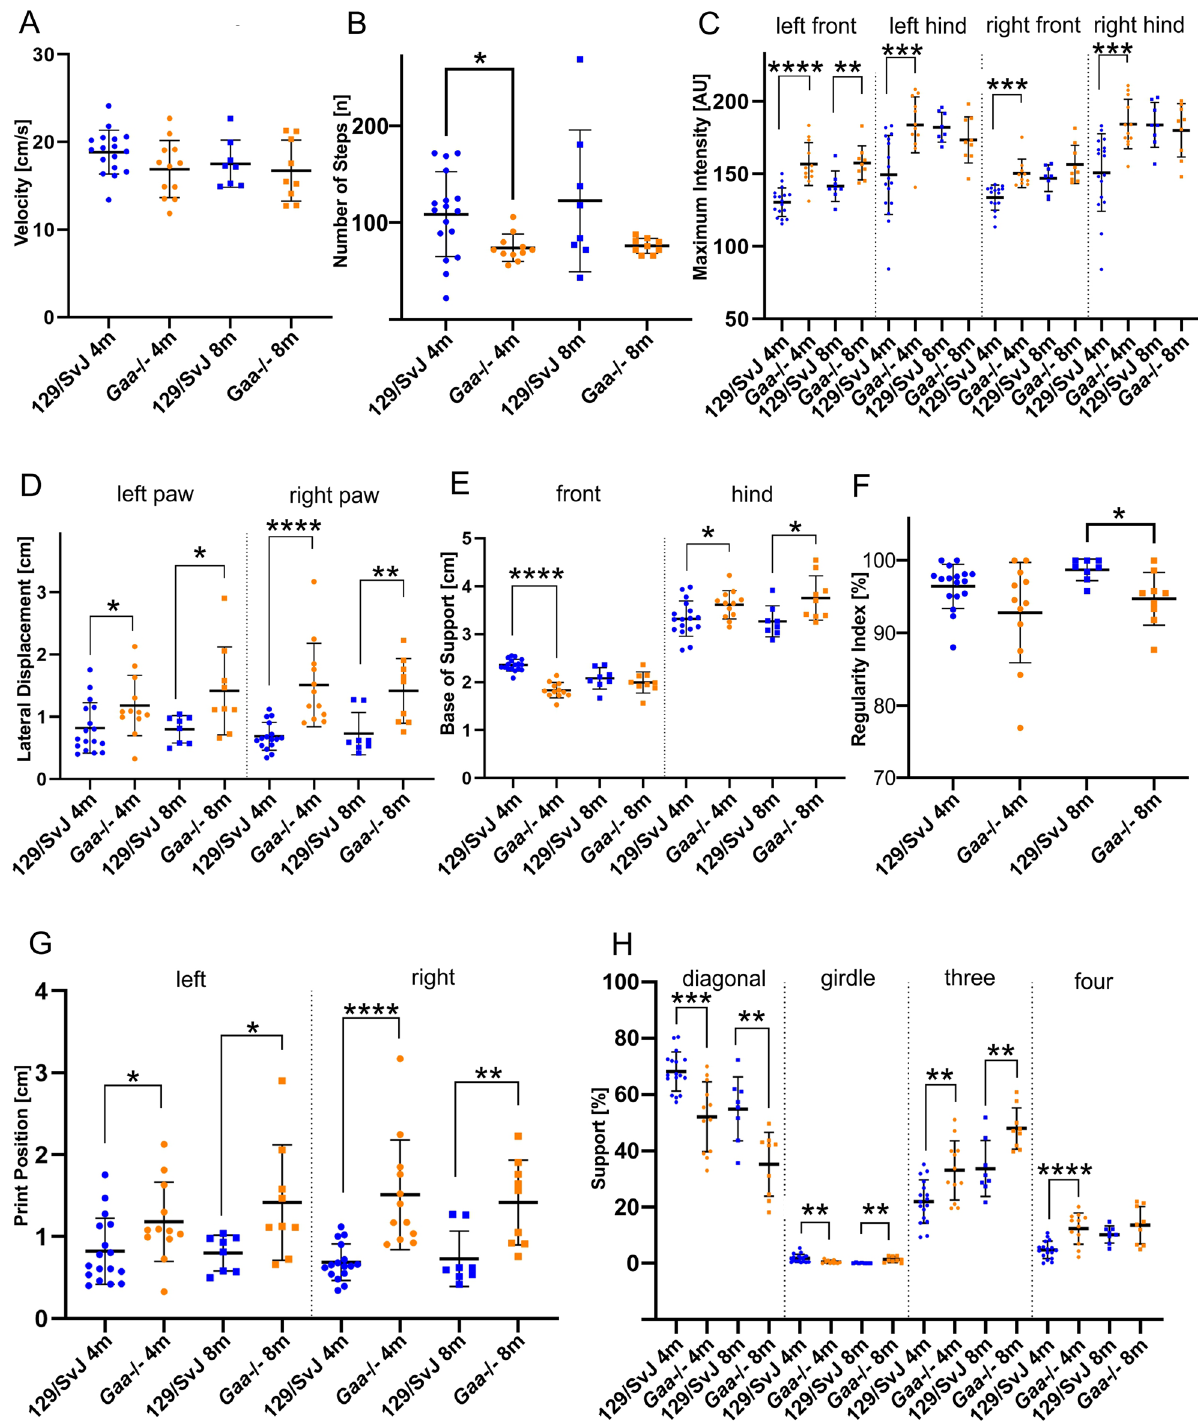
Figure 1. Gaa −/− mice have an abnormal motor coordination. Automatic gait analysis revealed that many general locomotor parameters were similar in wildtype 129/SvJ mice (blue dots) and Gaa −/− mice (orange dots), including velocity of movement ( A ) and number of steps (( B ); the slightly reduced number of in 4-month-old mice is most likely due to the weight difference). Other parameters are different between Gaa −/− mice and age-matched control mice due to their different muscle force, including the maximum intensity of the footprints ( C ). On the other hand, both mouse lines behaved differently with respect to locomotion coordination parameters, including the lateral displacement ( D ), the base of support for the front- and hind limbs ( E ), as well as the regularity index ( F ). The distance between the position of the hind paw and the position of the previously placed front paw on the same side of the body and in the same step cycle (print position) was increased on the left as well as on the right side in Gaa −/− mice ( G ) at both ages examined. Moreover, the time the mice were supported by contacting the ground with the diagonal and girdle sides limbs as well as the time the animal was supported by three or four limbs was longer in Gaa −/− mice compared to 129/SvJ control mice ( H ). For a complete list of gait parameters analyzed see Supplementary Table 1. The bars show the mean ± SD with N = 17 (4-month- old 129SvJ) and N = 12 (4-month-old Gaa −/− ), N = 8 (8-month-old 129SvJ), N = 9 (8-month old Gaa −/− ) mice. Statistical significance was calculated using the unpaired student’s